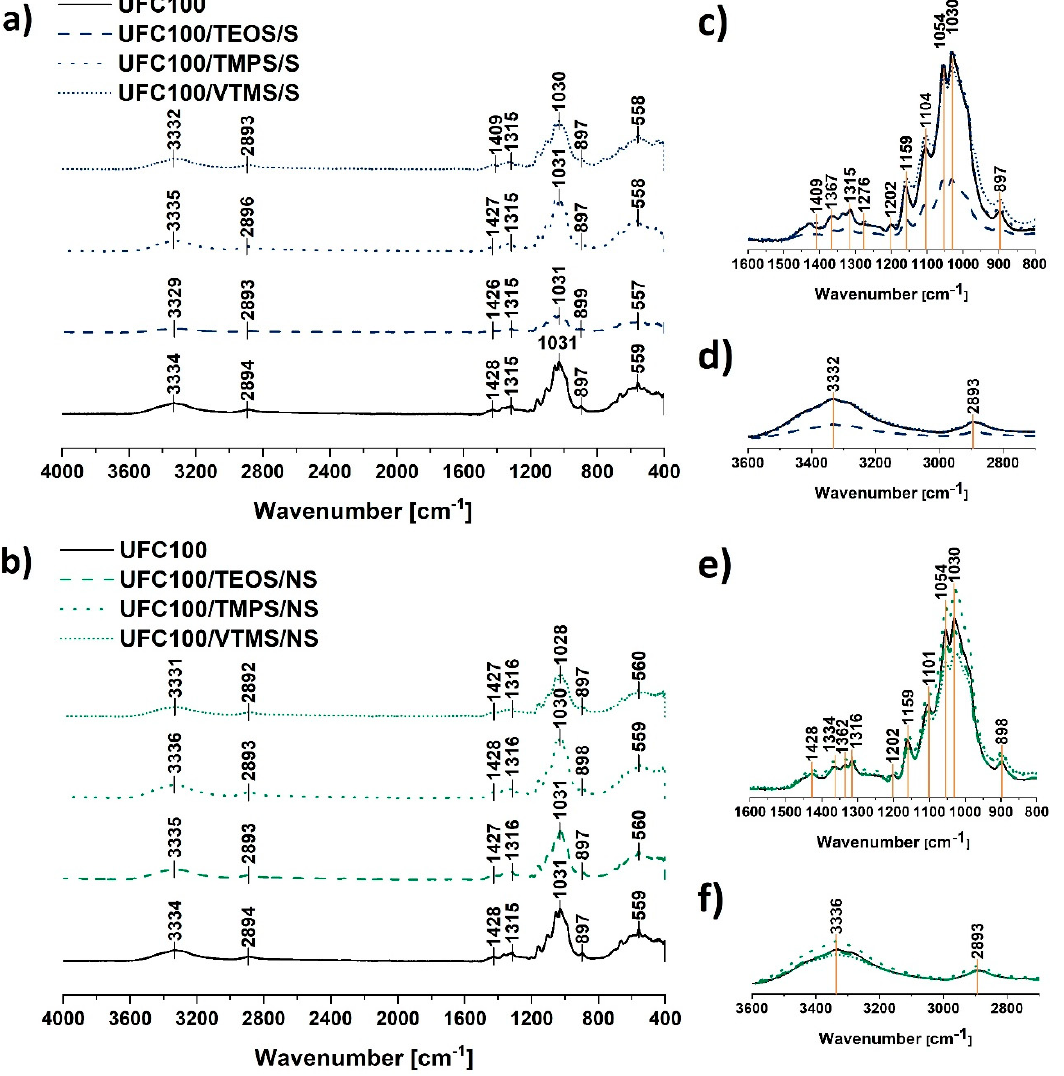
Figure 3. Fourier-transform infrared spectra of: ( a ) cellulose fibres modified via a solvent-involving method; ( b ) cellulose fibres modified via a non-solvent method. Characteristic absorption bands: 3334 cm − 1 (O–H, water), 2894 cm − 1 (C–H), 1200-900 cm − 1 (O–H, C–O, –COO,